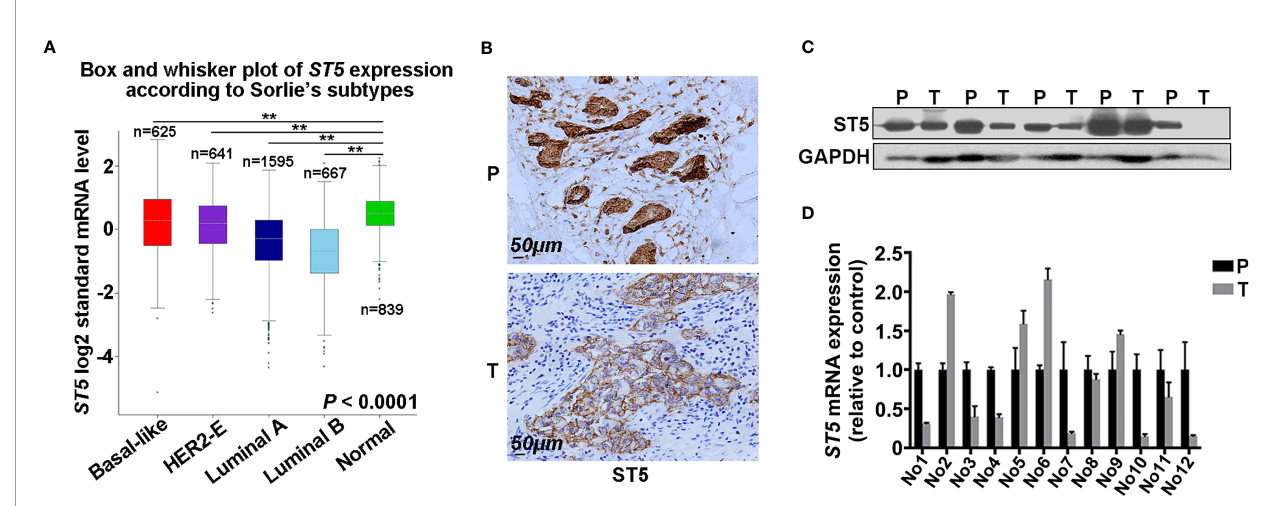
FIGURE 1 | Evaluation of ST5 expression in human breast cancer specimens. (A) ST5 gene expression as analyzed by using the bc-GenExMiner in different subtypes of human breast cancer tissues and normal breast tissues (n=839). The subtypes of human breast cancer included Luminal B subtype (n=667), Luminal A subtype (n=1,595), receptor tyrosine-protein kinase erbB-2 (HER2)-E subtype (n=641) and Basal-like subtype (n=625). ** indicated different subtypes of breast cancer vs. normal. (B) Immunohistochemical staining of ST5 in human breast cancer samples and its corresponding adjacent tissues. Scale bar: 50 m m. Protein expression (n=5) (C) and mRNA level (n=12) (D) of ST5 in human breast cancer tissues and its paired para-carcinoma tissues were measured by Western blotting and qRT-PCR, respectively. P, para-carcinoma tissues; T, tumor tissues. **P <